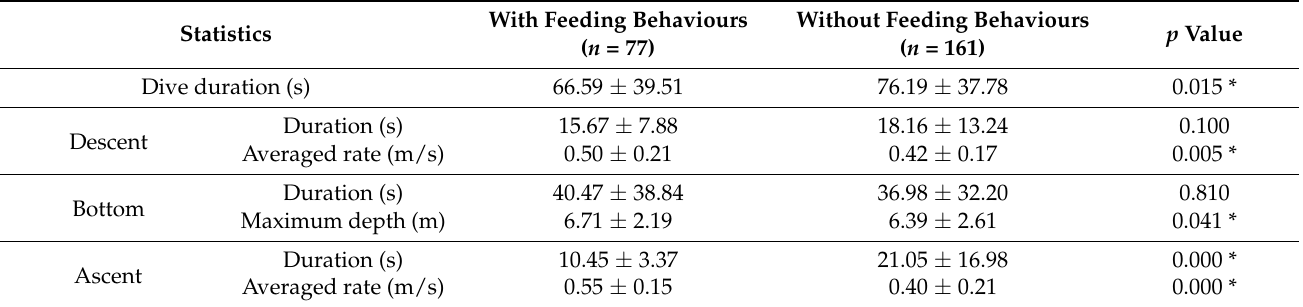
Table 3. Dives statistics (mean ± standard deviation and Mann–Whitney nonparametric test p values) for the two deep dive types. * p <